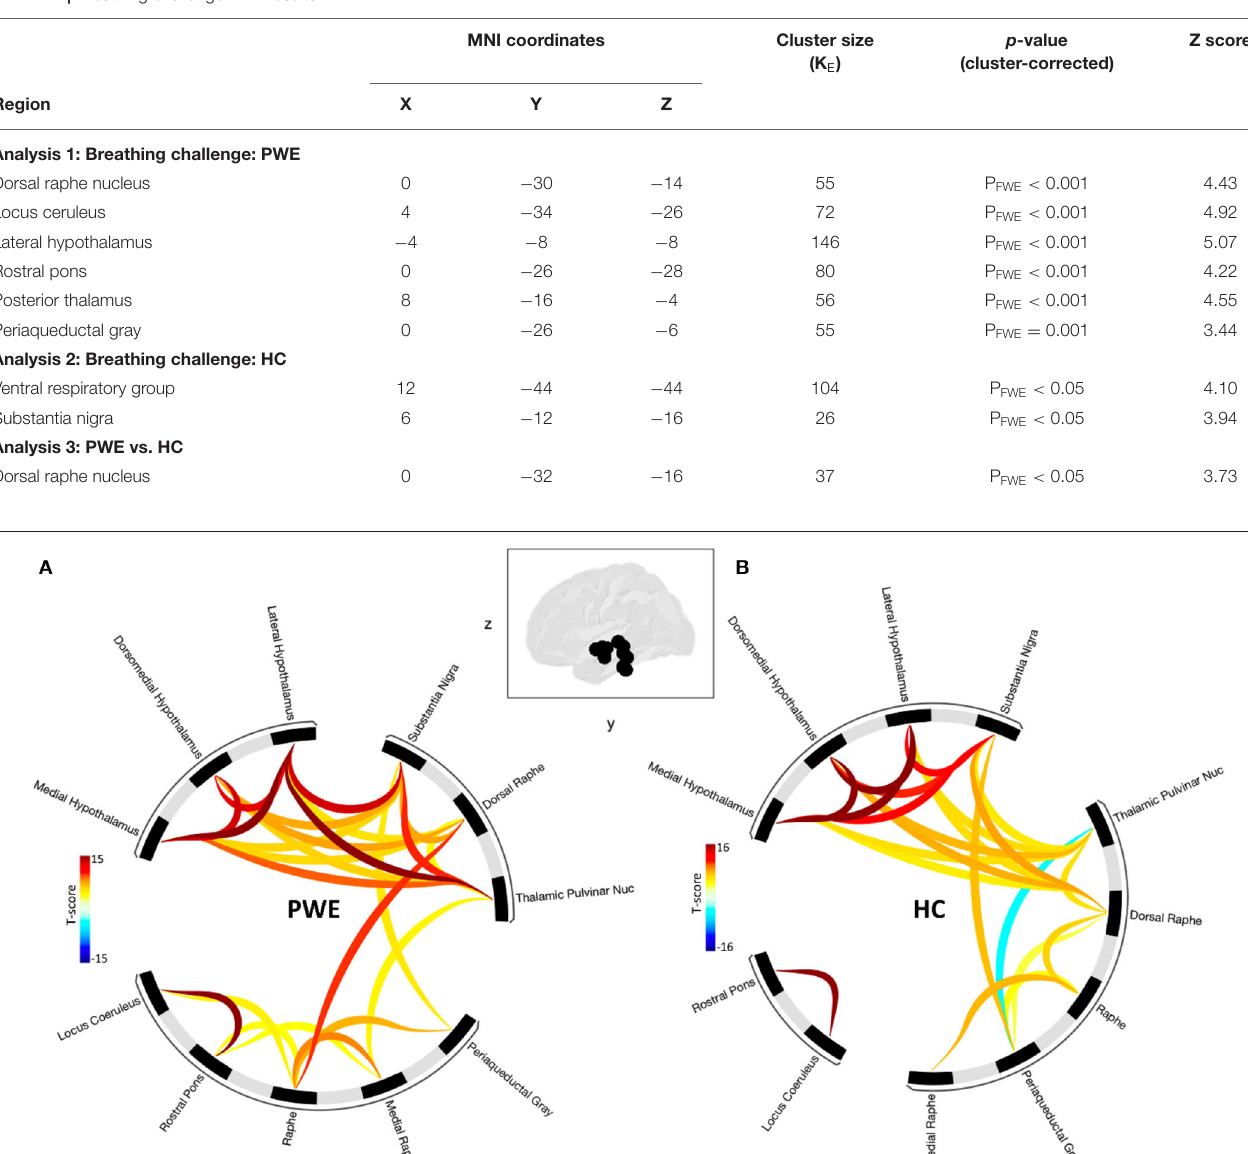
MNI coordinates Cluster size